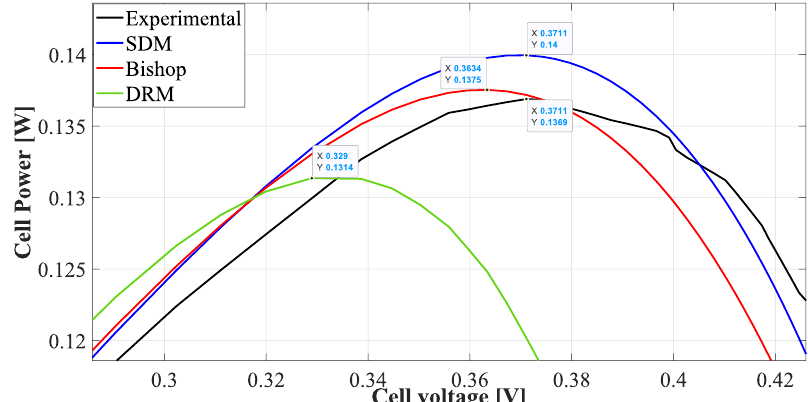
Figure 9. Maximum power point for each model .